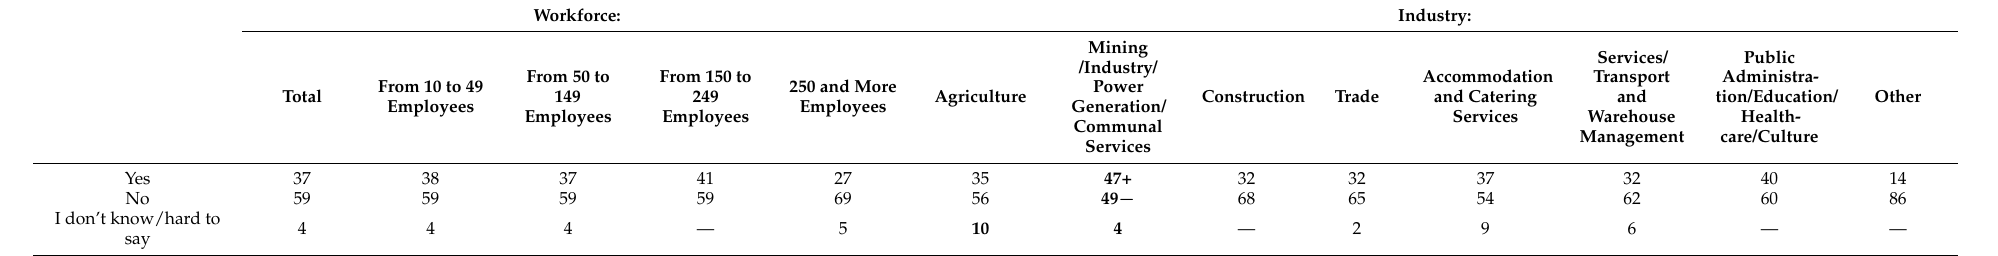
Table 1. Information about the so-called global warming is all about business—certain groups earn a lot of money by making people feel fear or guilt (in percentage points).